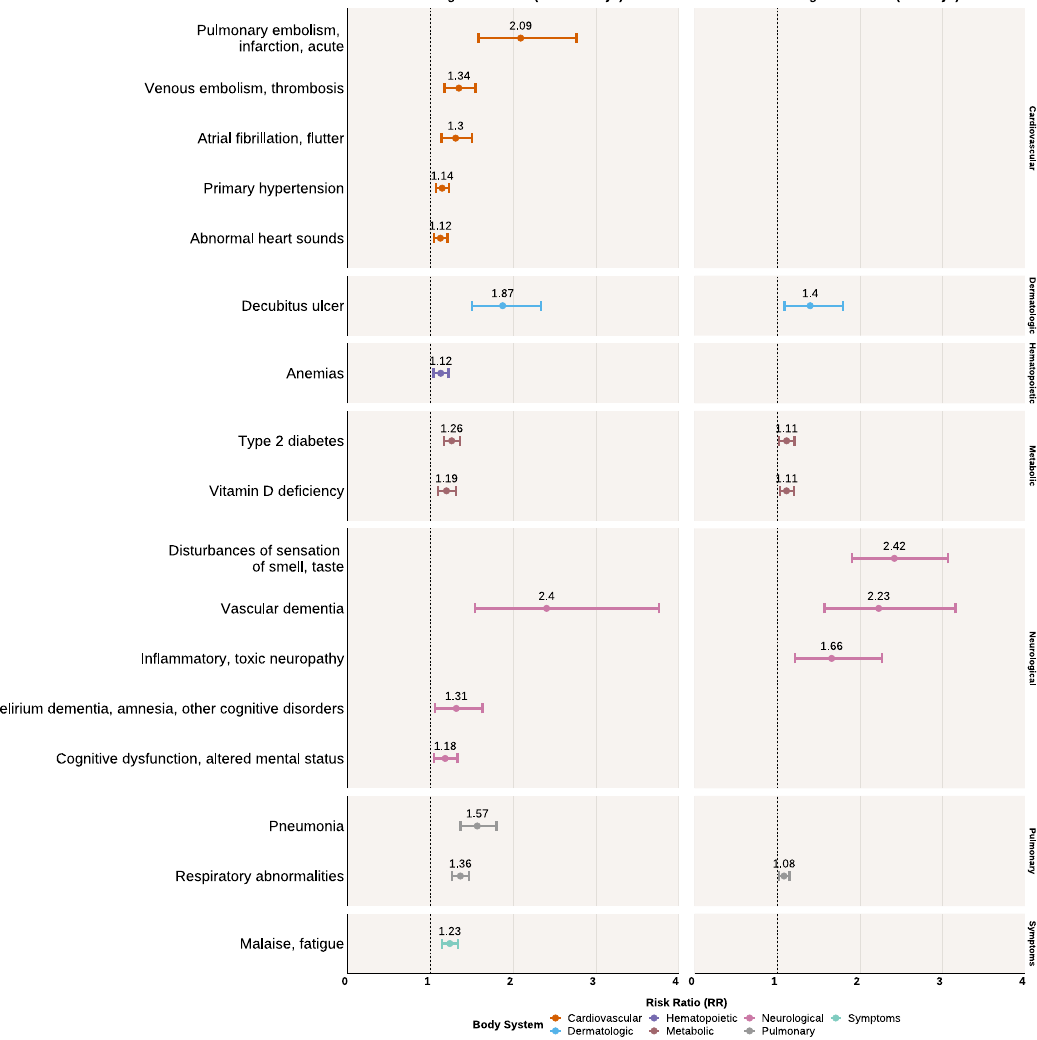
Fig. 4 Statistically signi fi cant risk ratios with 95% con fi dence intervals of health conditions in the outpatient COVID-19 cohort compared to the control outpatient cohort. Left panel shows diseases of increased risk at the mid-stage post-acute period (30 to 89 days after initial infection) among the outpatient COVID-19 cohort. Right panel shows diseases of increased risk at the late-stage post-acute period (90 + days after initial infection). P values were corrected for multiple comparisons with a 5% false discovery